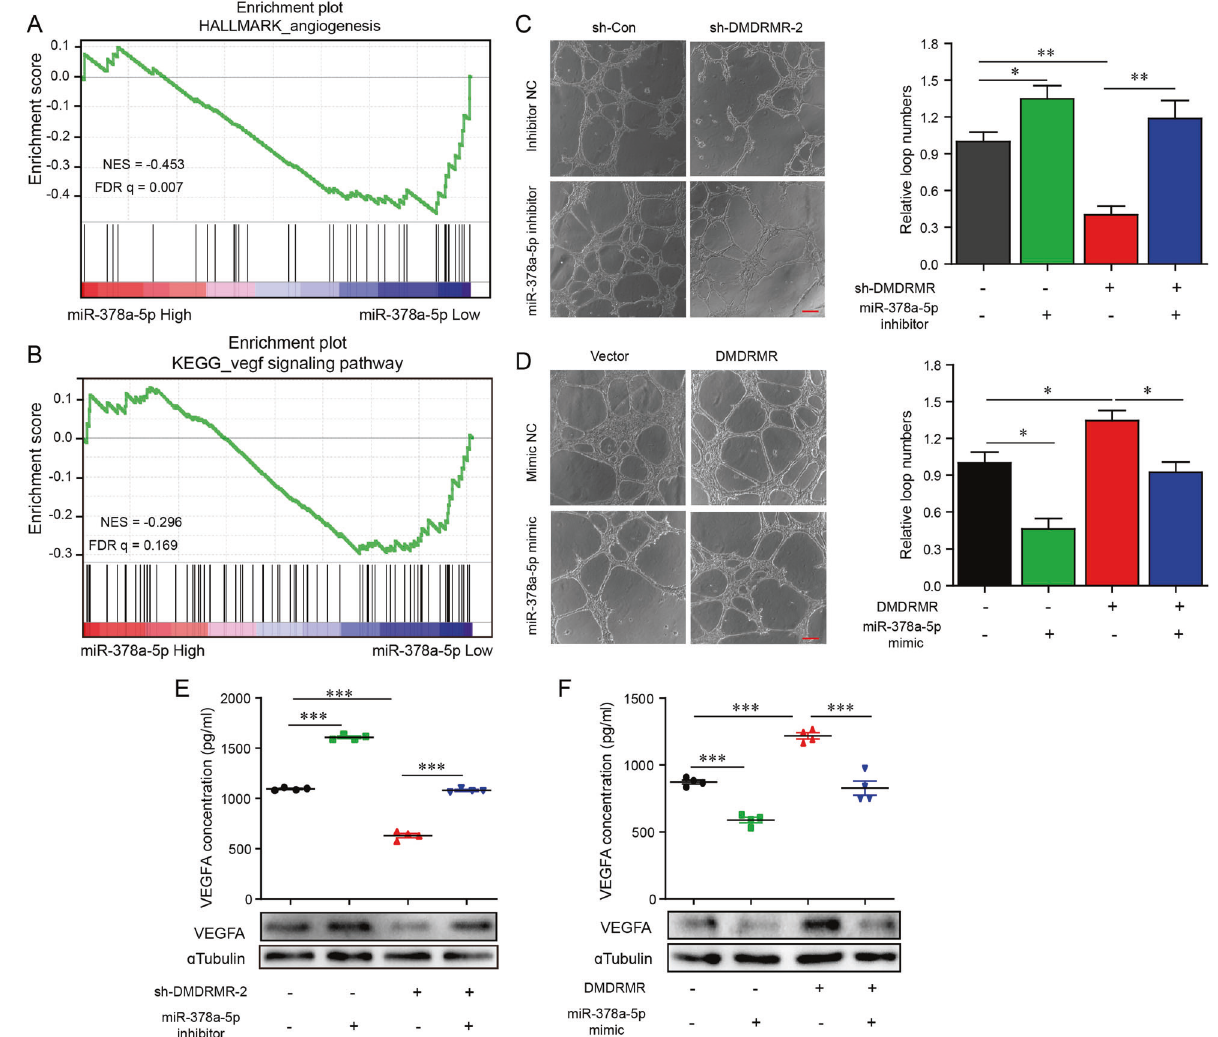
Fig. 4 DMDRMR induces angiogenesis through sequestering miR-378a-5p. A , B GSEA showing the enrichment of “ angiogenesis ” (Hallmark database, A ) and “ vegf signaling pathway ” (KEGG database, B ) in high (red) and low (blue) miR-378a-5p expression. C , D Representative bright- fi eld images (left) and quanti fi cations (right) of matrigel tube formation of HUVECs incubated with conditioned medium from DMDRMR KD 786-O cells transfected with miR-378a-5p inhibitor ( C ) and DMDRMR OE 769-P cells transfected with miR-378a-5p mimic ( D ) (scale bars, 200 µm). E , F ELISA assay detecting the secreted VEGFA levels in DMDRMR KD 786-O cells transfected with miR-378a-5p inhibitor ( E ) and in DMDRMR OE 769-P cells transfected with miR-378a-5p mimic ( F ). The results are presented as mean ± SEM. * p < 0.05, ** p < 0.01, *** p < 0.001. ns, no signi fi